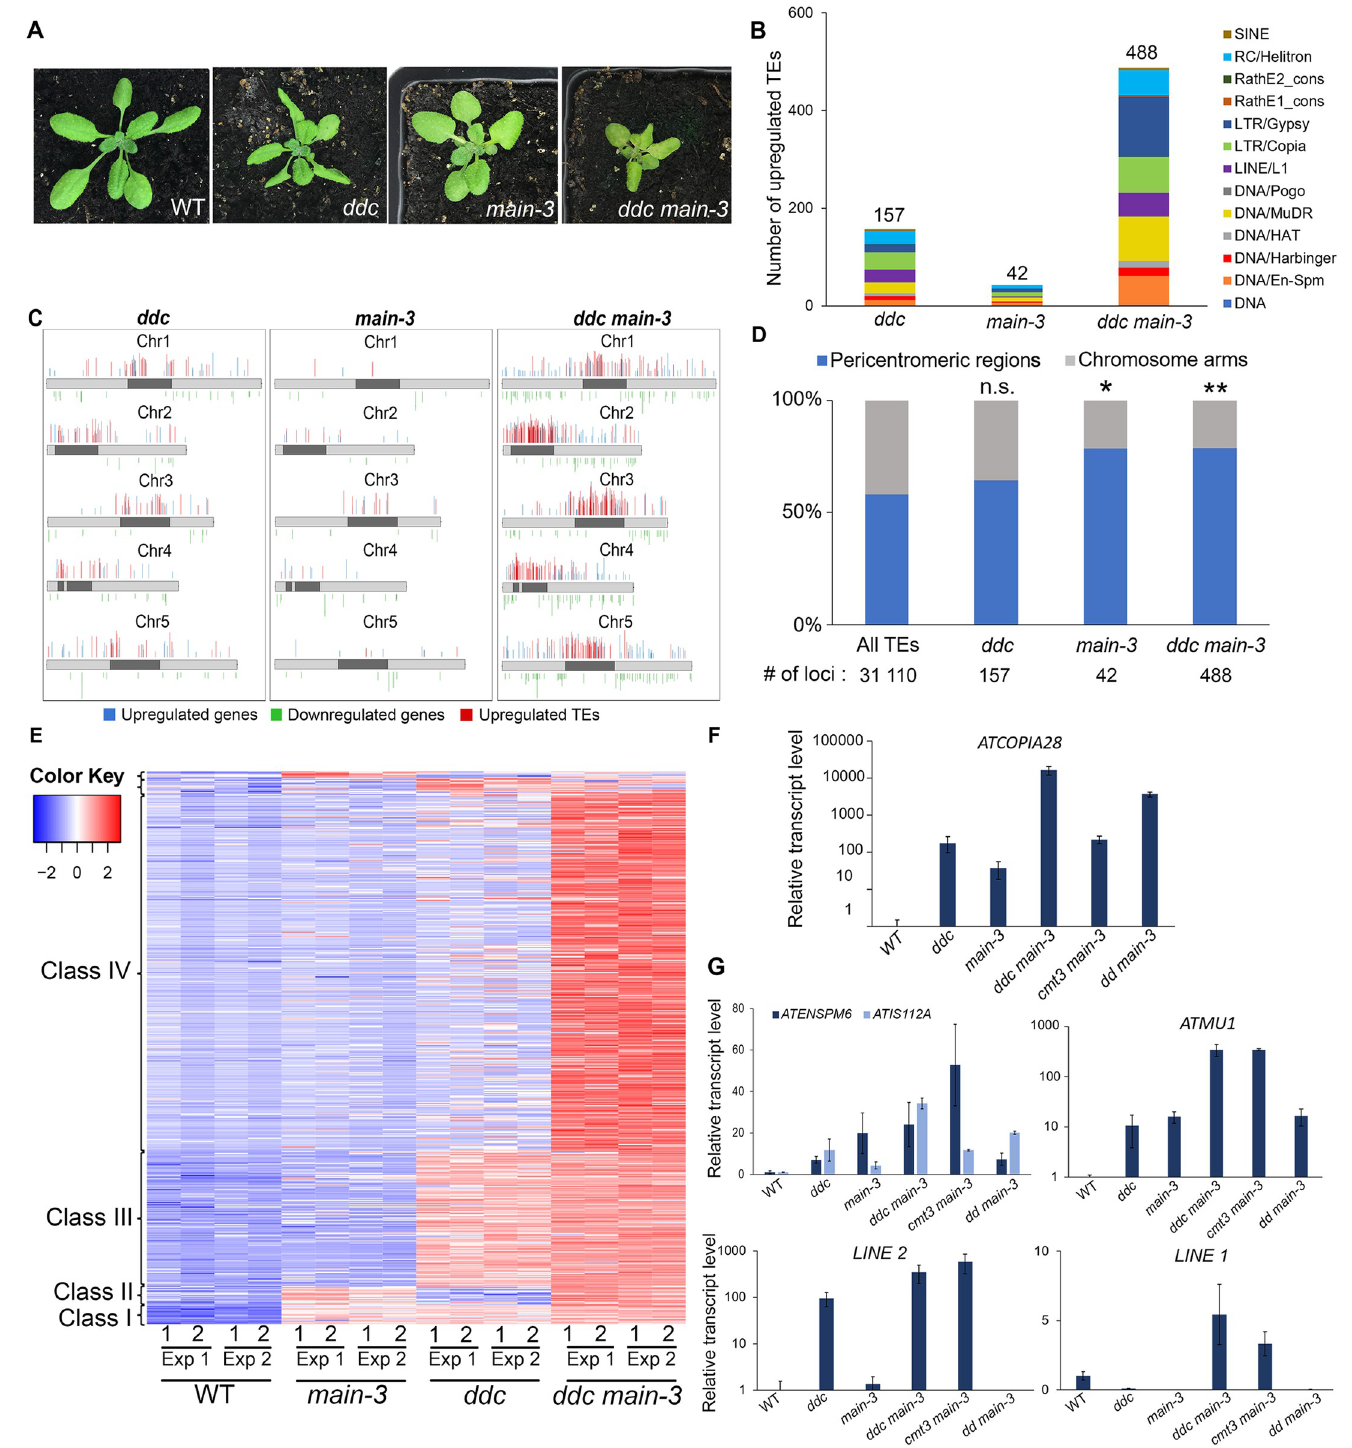
Fig 2. MAIN, DRM2 and CMT3 act synergistically to repress TEs. (A) Representative pictures showing the developmental phenotype of 3-week-old ddc , main-3 and ddc main-3 mutants in comparison to WT plant. (B) Number of upregulated TEs in ddc , main-3 and ddc main-3 , and classified by TE superfamily. (C) Chromosomal distributions of misregulated loci in ddc , main-3 and ddc main-3 over WT. Chromosome arms are depicted in light grey, pericentromeric regions in dark grey as defined in [50]. Upregulated genes and TEs are represented in blue and red, respectively; downregulated genes are represented in green. (D) Fraction of upregulated TEs in ddc , main-3 and ddc main-3 located in chromosome arms or in pericentromeric regions as defined in [50]. Asterisks indicate statistically